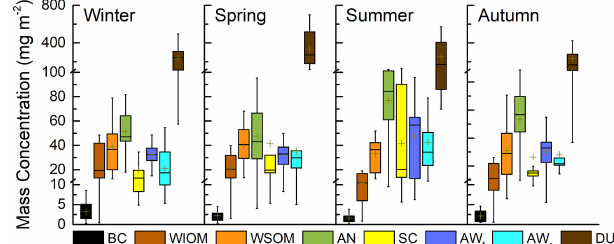
Figure 9. The mass concentrations of aerosol components in four seasons (winter, spring, summer and autumn). For the box-and- whisker plot, the mean value is indicated by a plus sign ( + ), and the median value is indicated by a short line inside the box ( − ). The top and bottom edges of each box represent the top and bottom quar- tiles (Q3 and Q1), and the corresponding whiskers are the outliers (Q3 + 1.5IQR and Q1 − 1.5IQR; IQR is interquartile range).